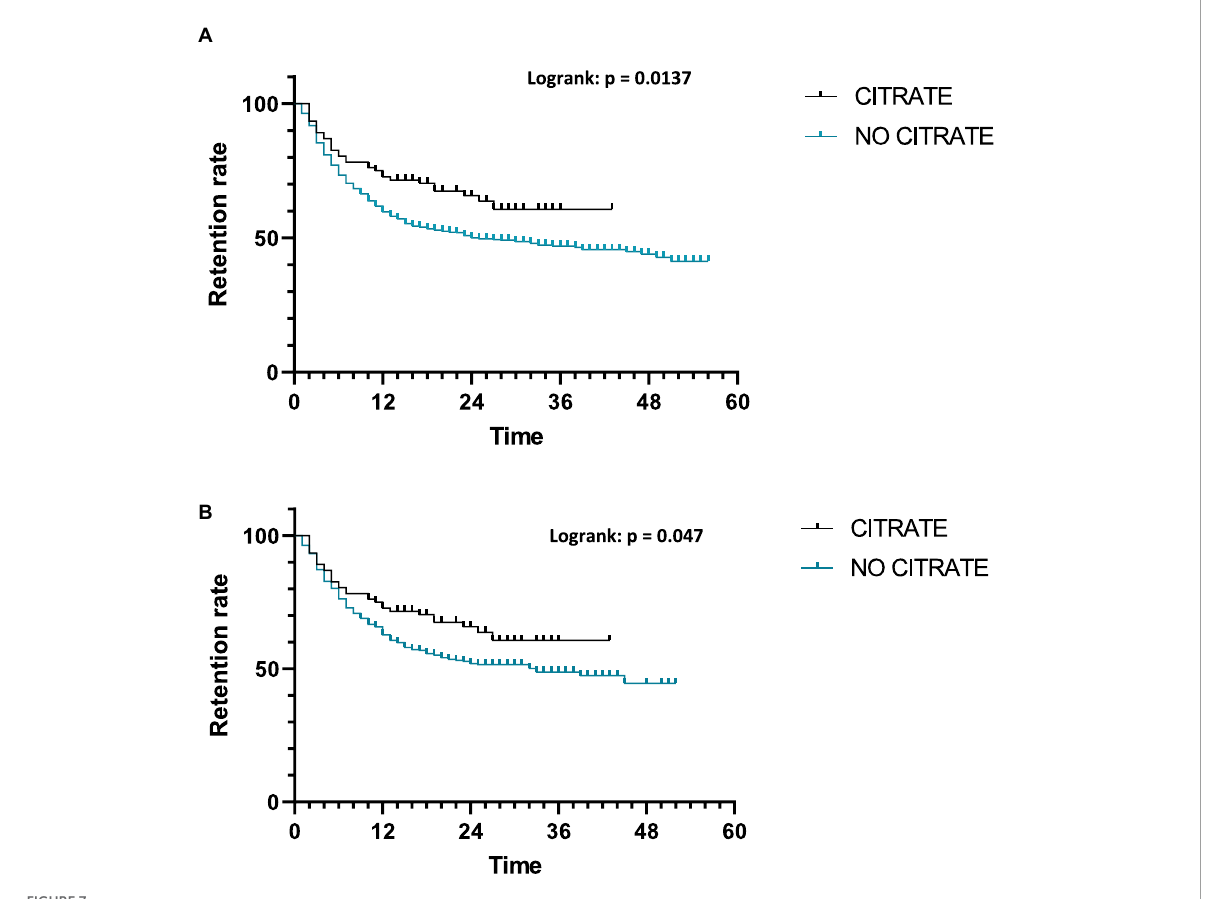
FIGURE7 Retention of treatments depending on citrate presence. (A) All treatments; (B) bsDMARDs only.